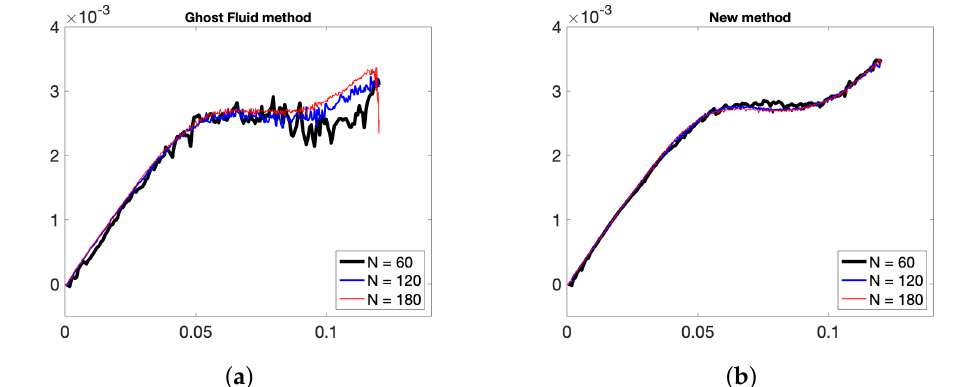
Figure 15. Evolution in time of partial x-momentum of air N = 60, 90, 120 points in x-direction with ( a ) Ghost Fluid method, ( b ) new method.